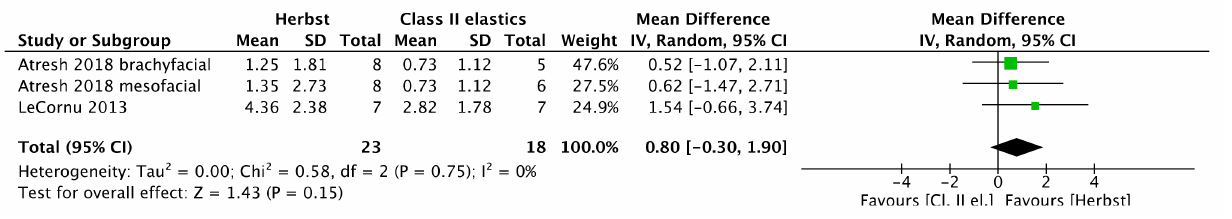
Figure 11. Forest plot of Pg point anteroposterior changes using the random effects model [43,44].